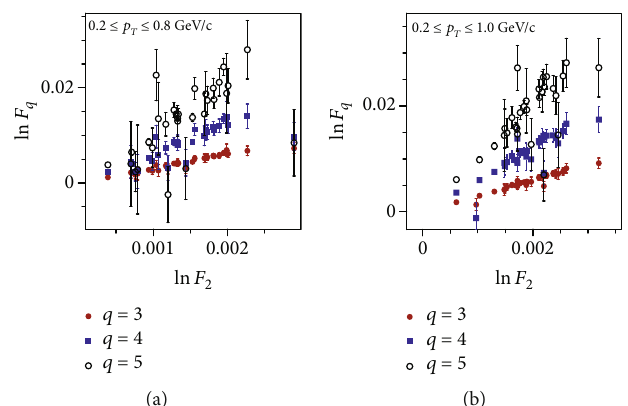
F 2 for EPOS3-hydro+cascade events for the